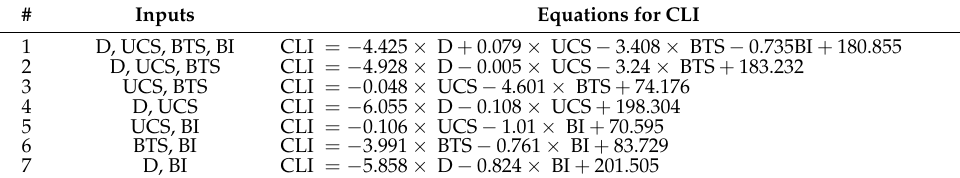
Table 7. Results of multi-variable linear regression of CLI as function of other rock properties.